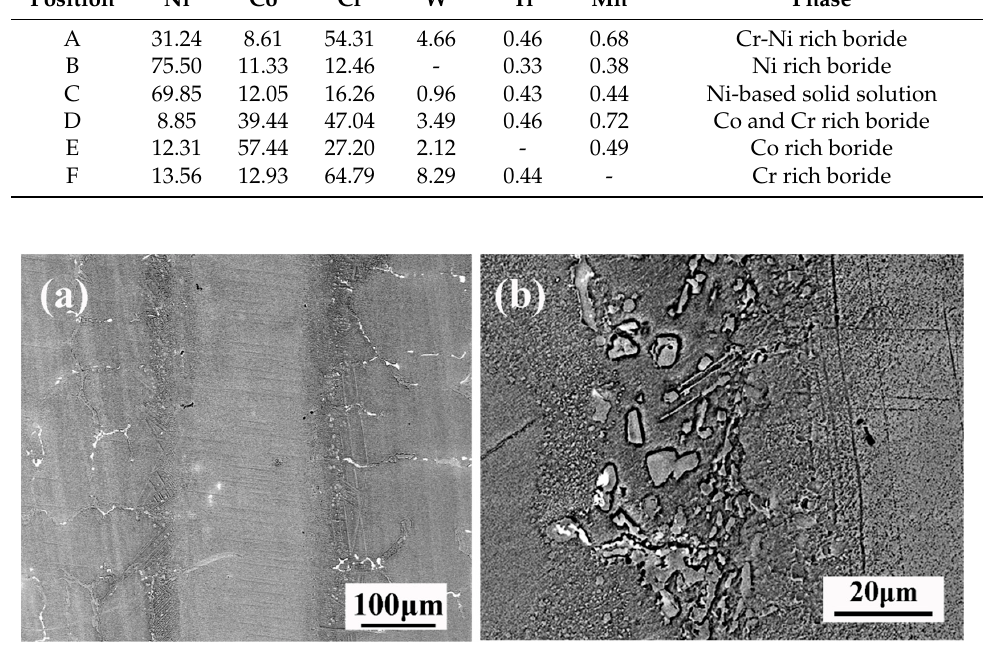
Figure 5. Typical microstructure of TLP-bonded joints of DZ40M at 1160 ° C /30 min: ( a ) integral view; ( b ) DAZ.